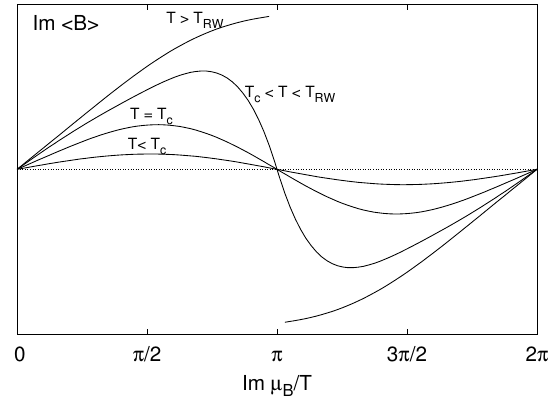
Figure 1 . Cartoon for the imaginary baryon number (Im (cid:31) B chemical potential. T RW is the temperature of the Roberge-Weiss critical